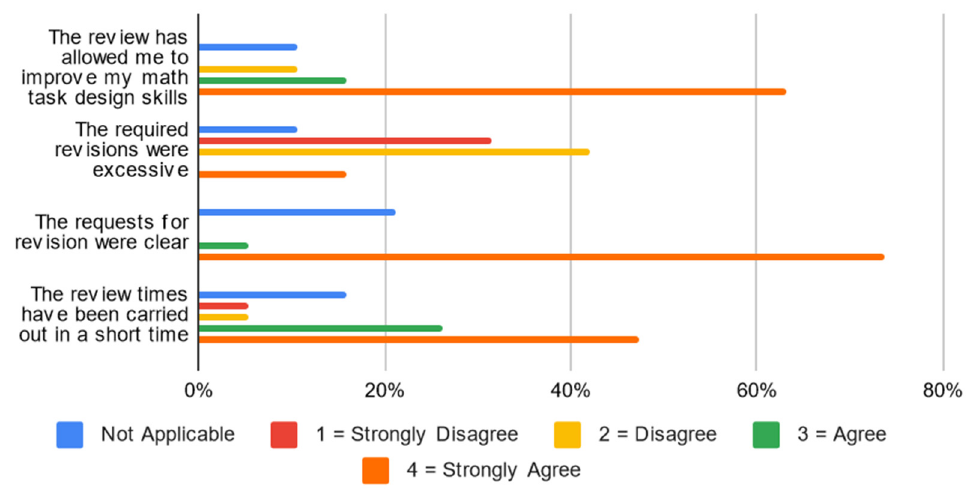
Figure 12. Opinions on the review process.